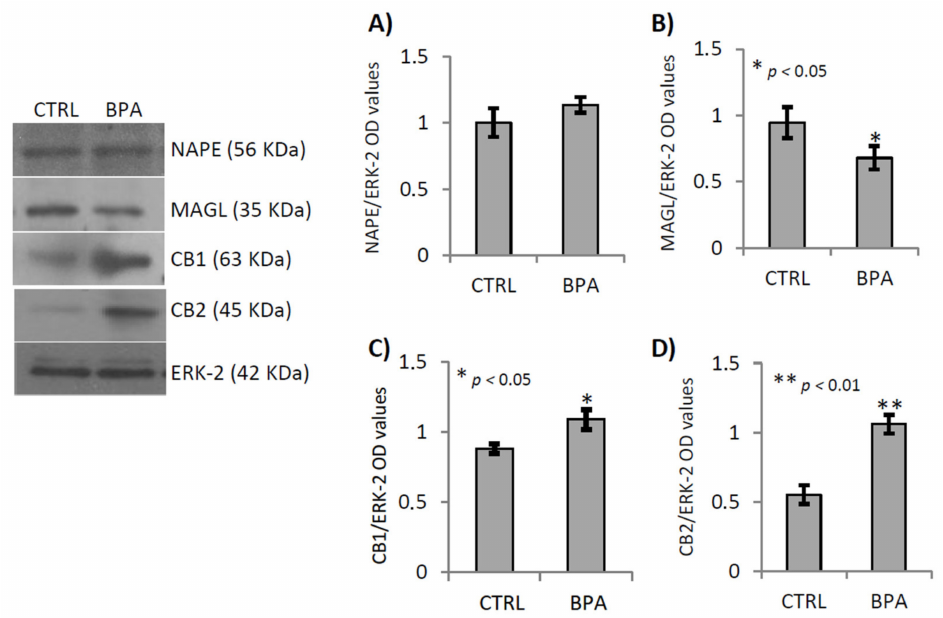
Figure 4. Gene expression analysis of ECS components in testis of male mice early-life exposed to vehicle (CTRL, n = 3/4) or BPA (BPA, n = 4) and sacrificed at 78 dpp . Western Blot analysis of NAPE, MAGL, CB1 and CB2. Protein amounts were quantified by densitometry analysis, normalized against ERK-2 signals, and expressed in OD values as fold change ( A – D ). All data were reported as mean value ± S.E.M. (*: p < 0.05; **: p <